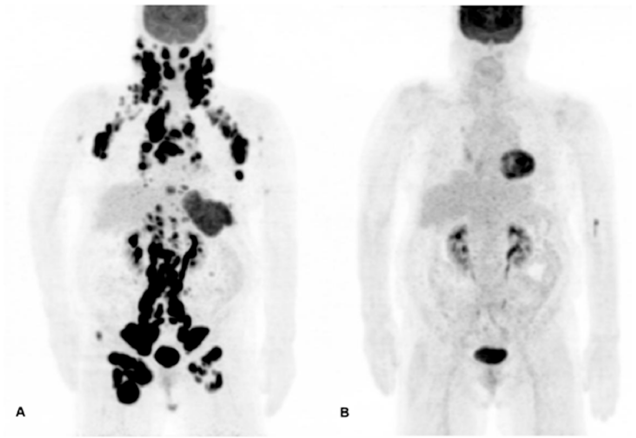
Figure 4. 18 F-Fluorodeoxyglucose (FDG) PET /CT imaging of the effect of R-CHOP therapy in a patient with follicular lymphoma. A 70-year-old female patient was diagnosed with follicular lymphoma after lymph node excision. The initial 18 F-FDG PET/CT imaging ( A ) revealed hypermetabolic lesions